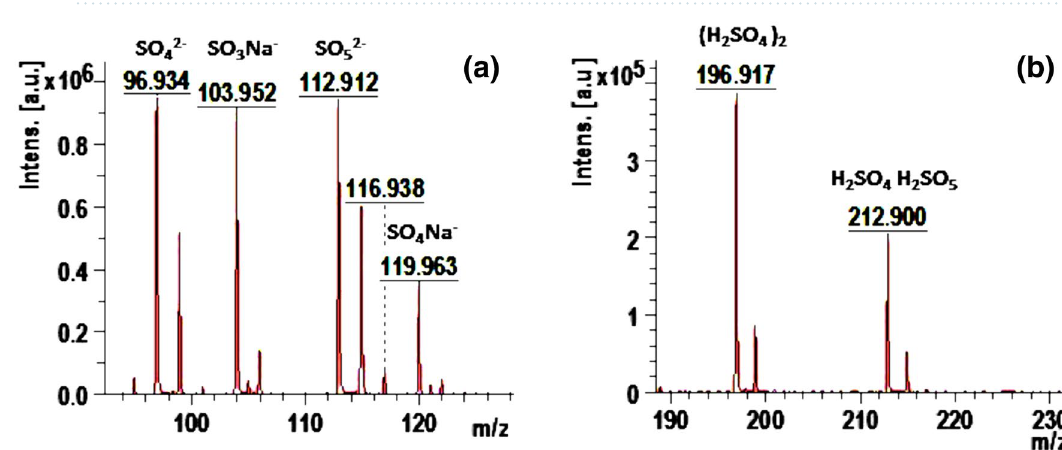
Figure 14. Zoomed areas of the MALDI–TOF–MS spectra of aqueous solution after 3 h discoloration/ degradation of AG-25 dye solution at pH = 3, over Ch-rGO/Fe 3 O 4 nanocatalysts (0.010 g) and H 2 O 2 (0.1